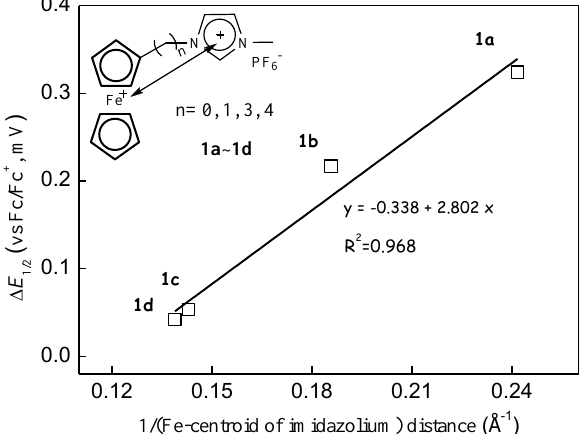
Figure 3. The mean potential of 1-ferrocene alkylmethylimidazolium salts 1a – 1d vs. Fe-centroid of